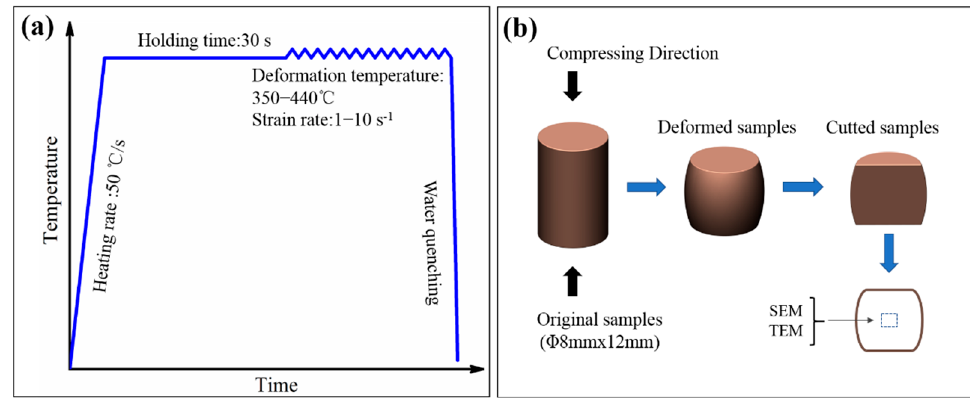
Figure 1. ( a ) Schematic diagram of compression test process parameters, ( b ) schematic diagram of compression and cut samples of deformed samples.